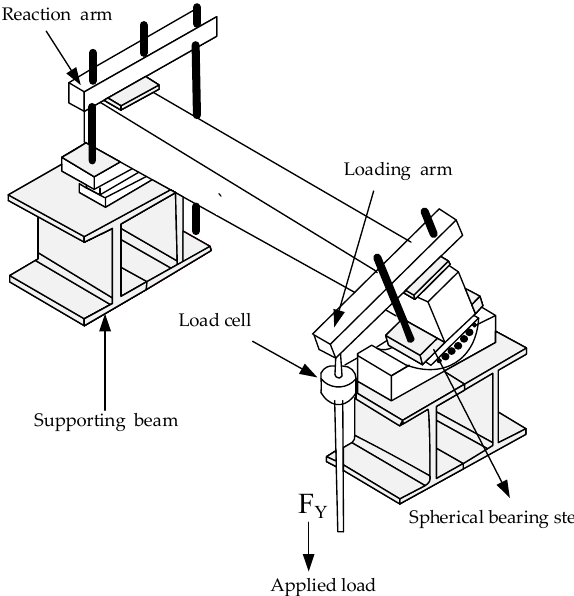
Figure 5. Experimental test setup under torsional behavior.